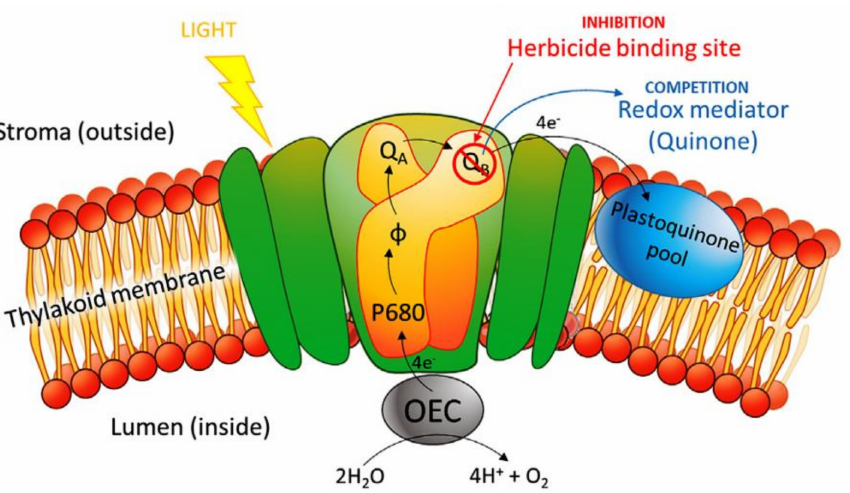
Figure 6. A diagrammatic representation of the photosynthesis inhibition by herbicides. Reproduced from Reference [50] with permission. Copyright 2019,